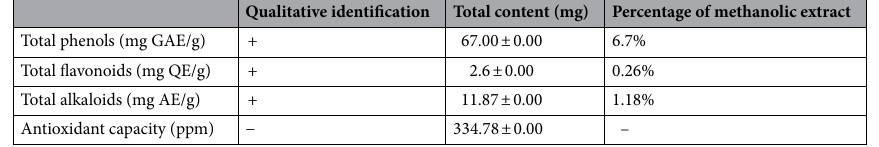
Table 1. Total contents of phenols, flavonoids, and alkaloids in the methanolic extract of P. laevigata leaves. + qualitative presence, − no determined.